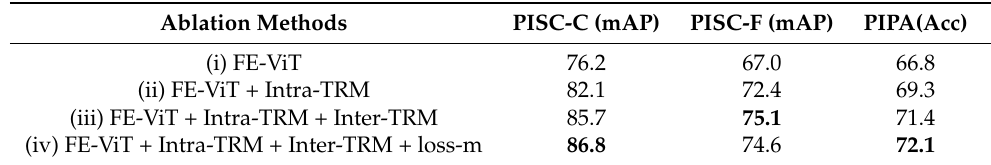
Table 4. Ablation results with row 1 to row 5 corresponding to the results of ablation (i) to ablation (v). The best results are given in